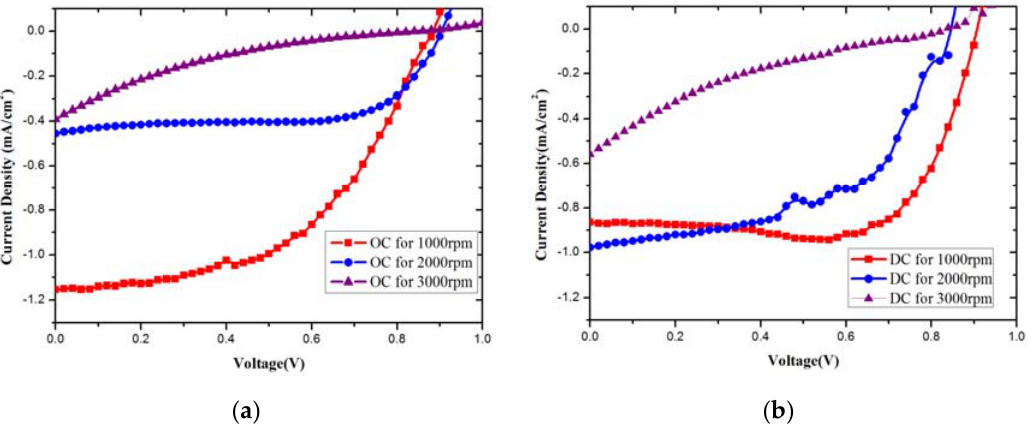
Figure 2. The current density ‐ voltage (J ‐ V) curves of device with different spin ‐ coating speed of ( a ) original concentration (OC) TiO 2 and ( b ) double concentration (DC) TiO 2 . Table 1. Photovoltaic performance of perovskite solar cells with di ff erent TiO 2 concentration and various spin-coating